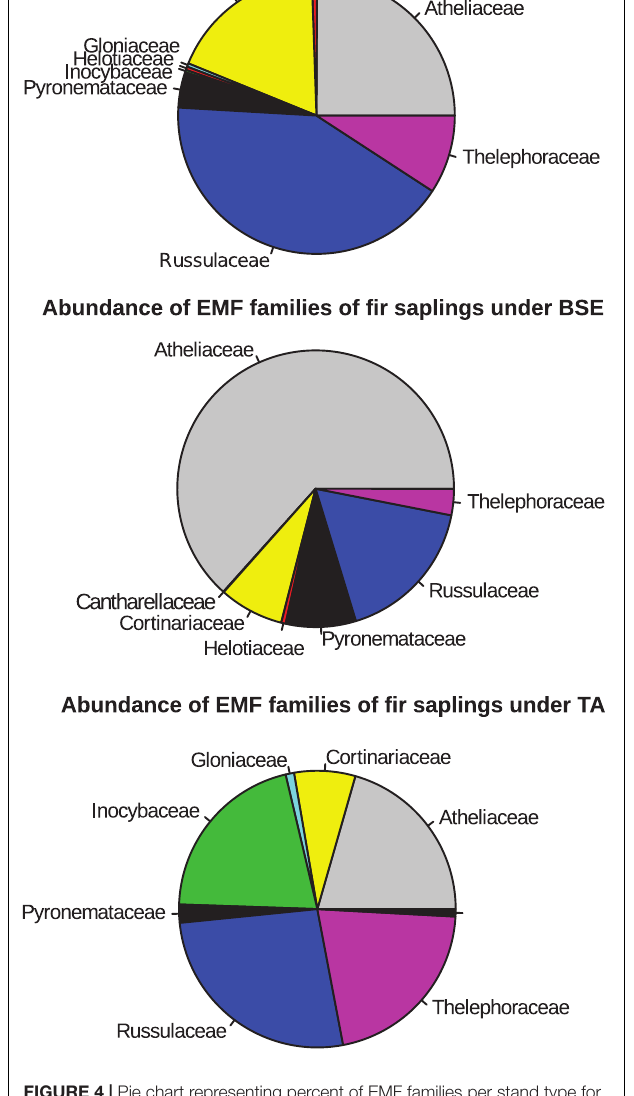
Ectomycorrhizal